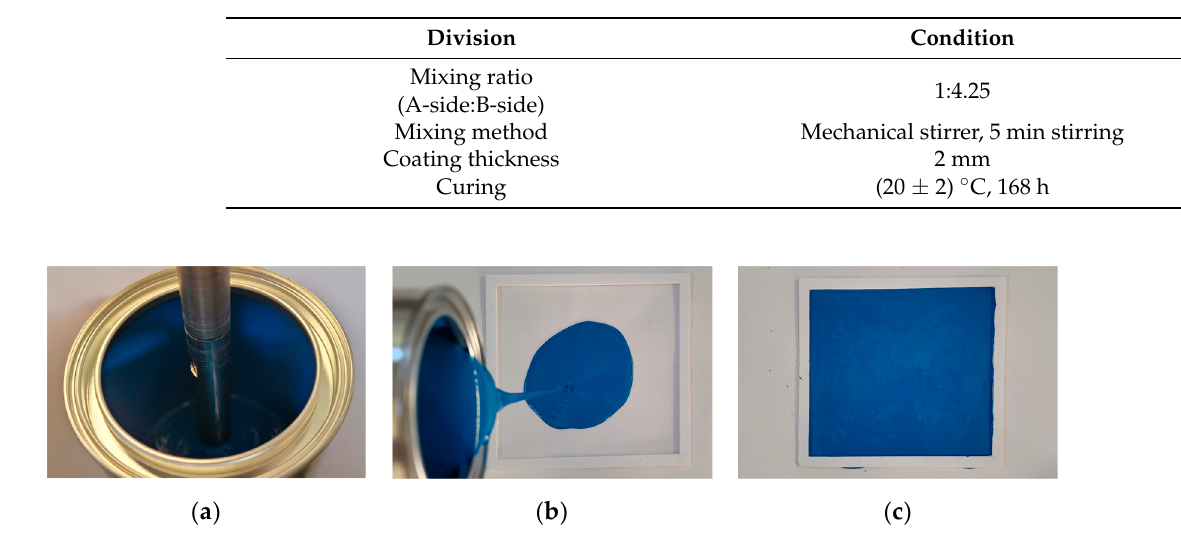
Figure 6. The specimen fabrication process: ( a ) stirring ; ( b ) coating ; ( c ) curing.